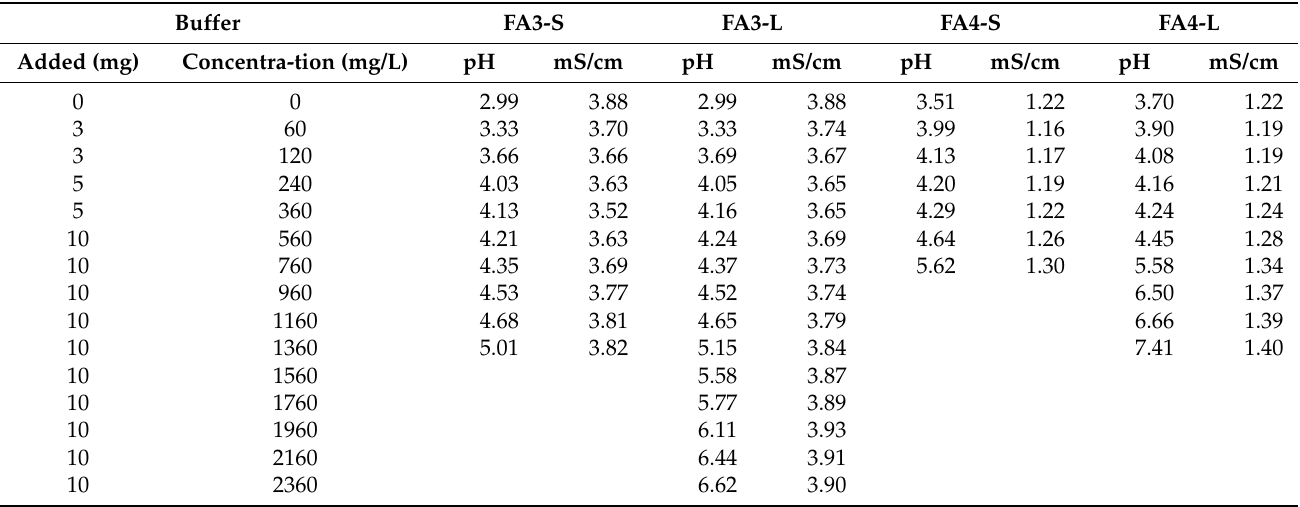
Table 5. Variation of acidity and conductivity during buffering step on samples FA3-S, FA3-L, FA4-S and FA4-L as a function of the buffer amount added.